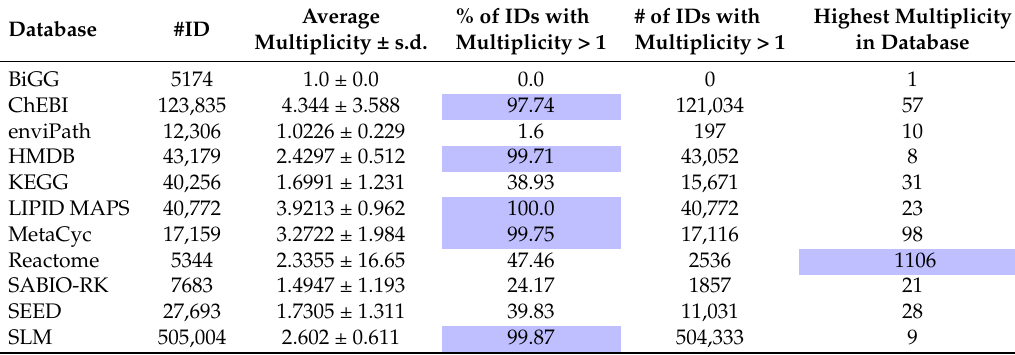
Table 2. ID multiplicity in each database: number of IDs in each database, average number of names per ID (average multiplicity), percentage and number of IDs that associate to more than one name, and highest number of names an ID links to; s.d. stands for standard deviation. Blue boxes are used to highlight highest